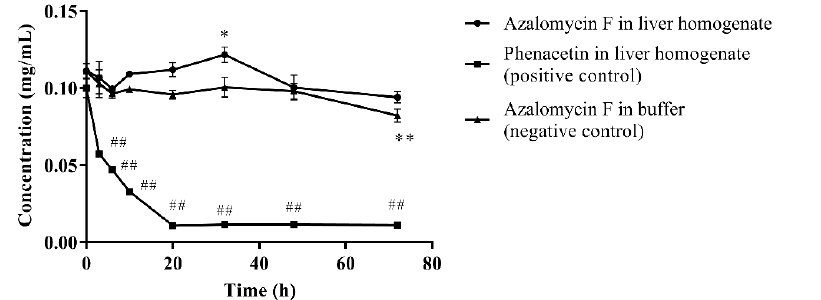
Figure 2. Metabolism of azalomycin F by liver homogenate ( n = 3). ## indicates that the residual concentration of phenacetine at a given time point in the positive control incubation system was significantly different from that at 0 h ( p < 0.01); ** indicates that the residual concentration of azalomycin F at a given time point in the negative control incubation system was significantly different